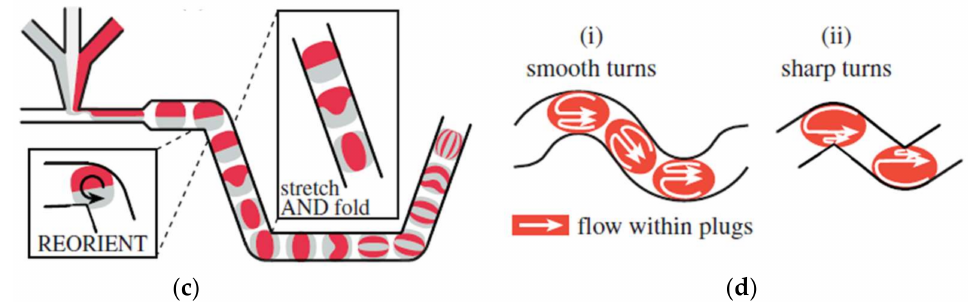
Figure 1. ( a ) Dispersion of solutes along the channel, reprinted with permission from [7]. ( b ) Microscopic image of the droplet in curved channel. ( c , d ) Recirculating flow scheme of Baker’s transformation in curved channel, reprinted with permission from [32].